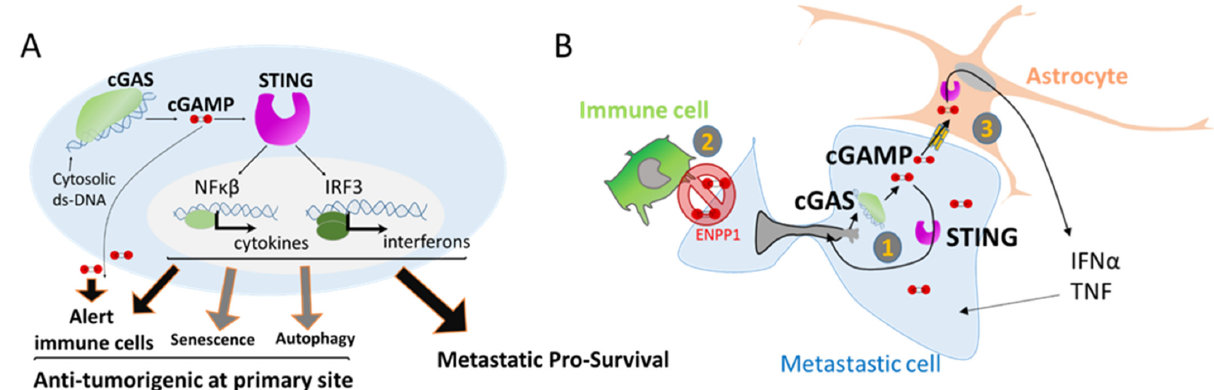
Figure 5. The activation of cGAS can support metastasis survival. ( A ) Activation of